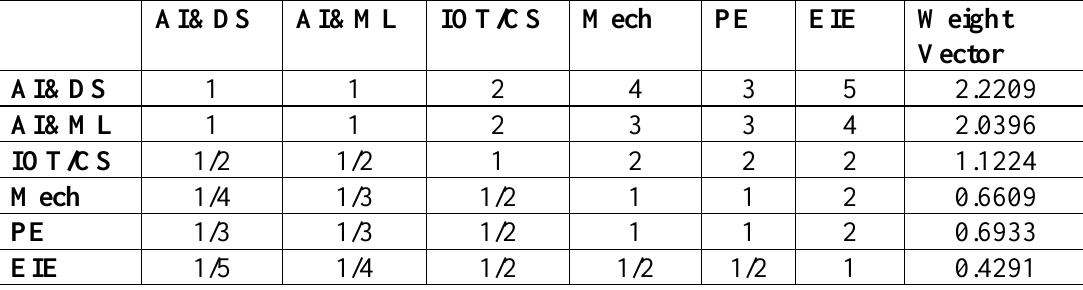
(Right Employability Skills) 2